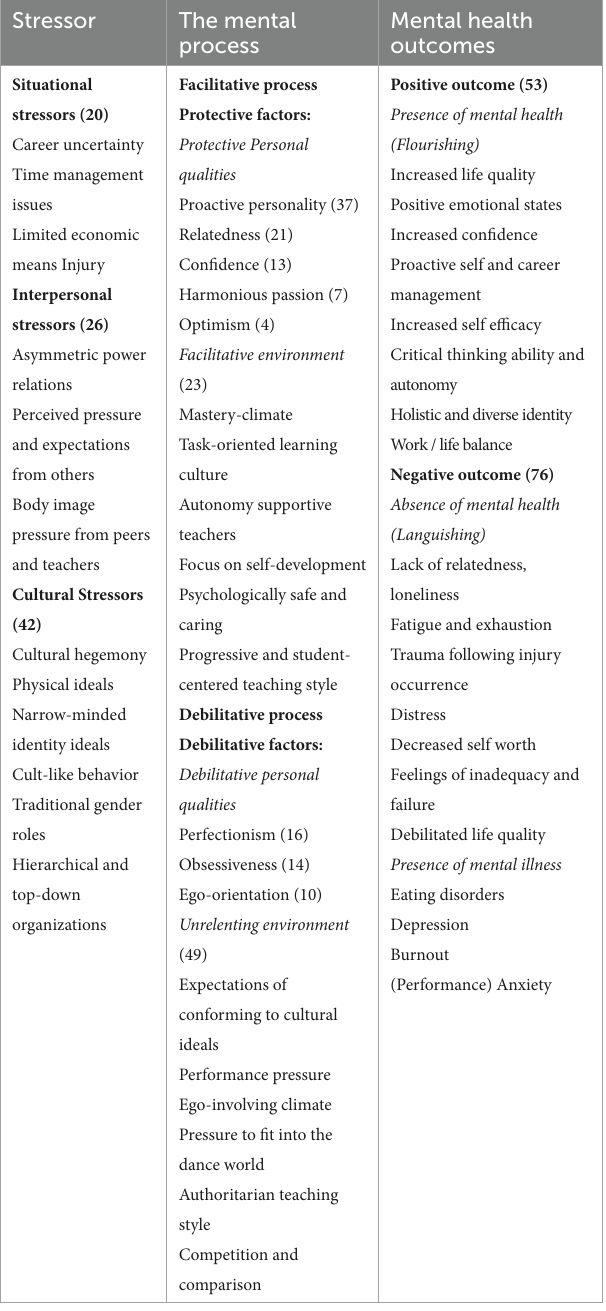
TABLE 3 Overview over themes and their